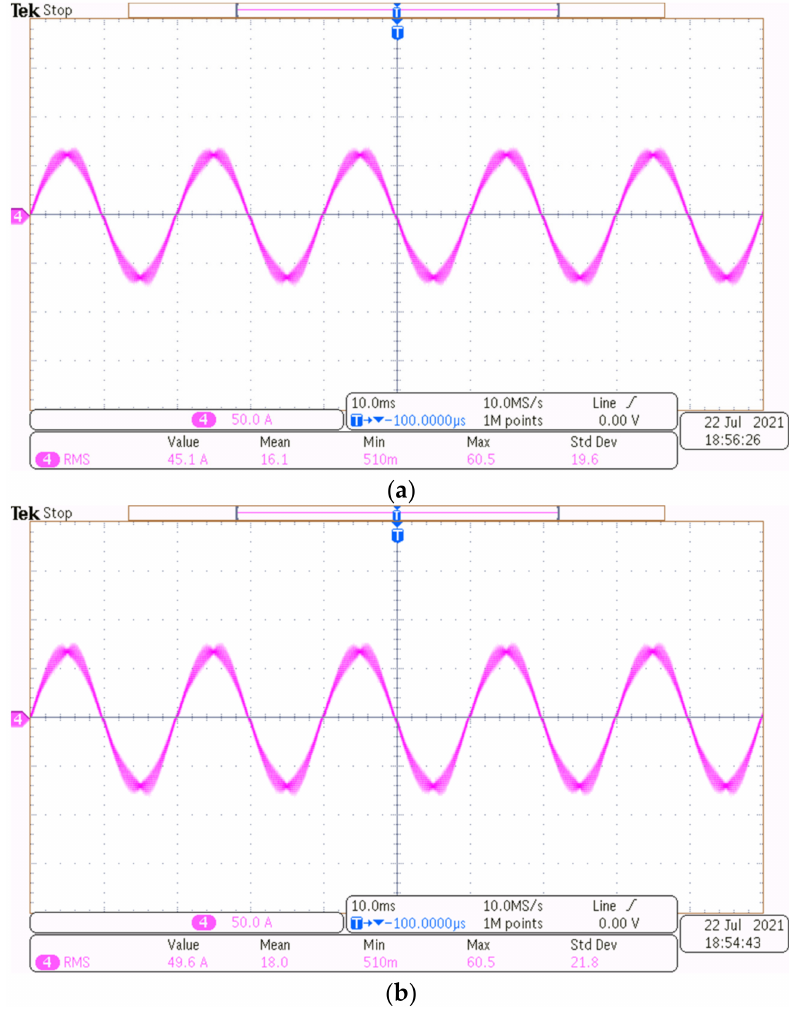
Figure 11. Experimental results with different magnitudes of output current reference when the loop gain compensation unit is introduced: ( a ) magnitude of output current reference is 60 A; ( b ) magnitude of output current reference is 70